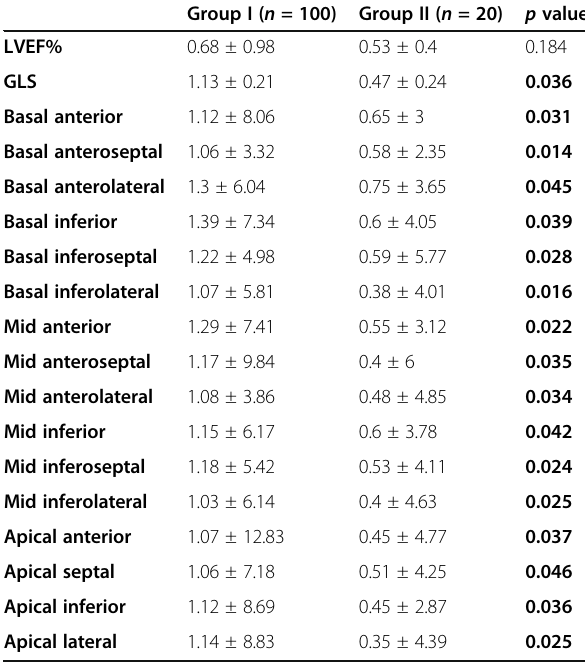
Table 3 Absolute changes in GLS, segmental strain and estimated LVEF% after receiving antiviral treatment between studied groups